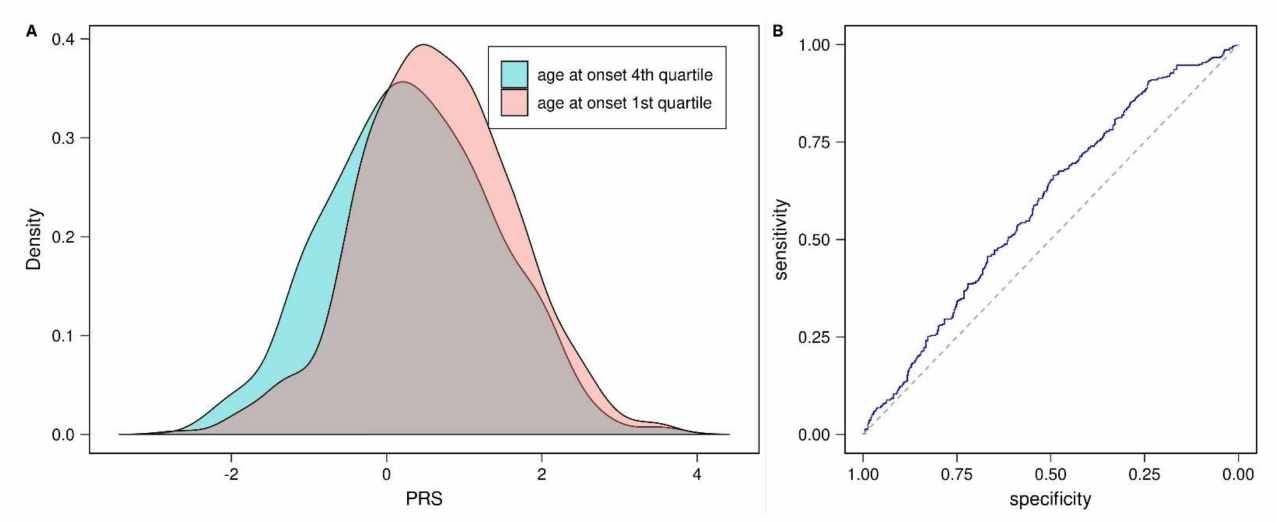
Figure 3. PD-PRS in early and late onset cases. ( A ) Density of PD-PRS in the 1st and 4th AAO quartile of cases. ( B ) ROC curve for PD-PRS as a predictor of 1st vs 4th AAO quartile. AAO: age-at-onset, PRS: polygenic risk score, PD: Parkinson’s disease, ROC: receiver operating